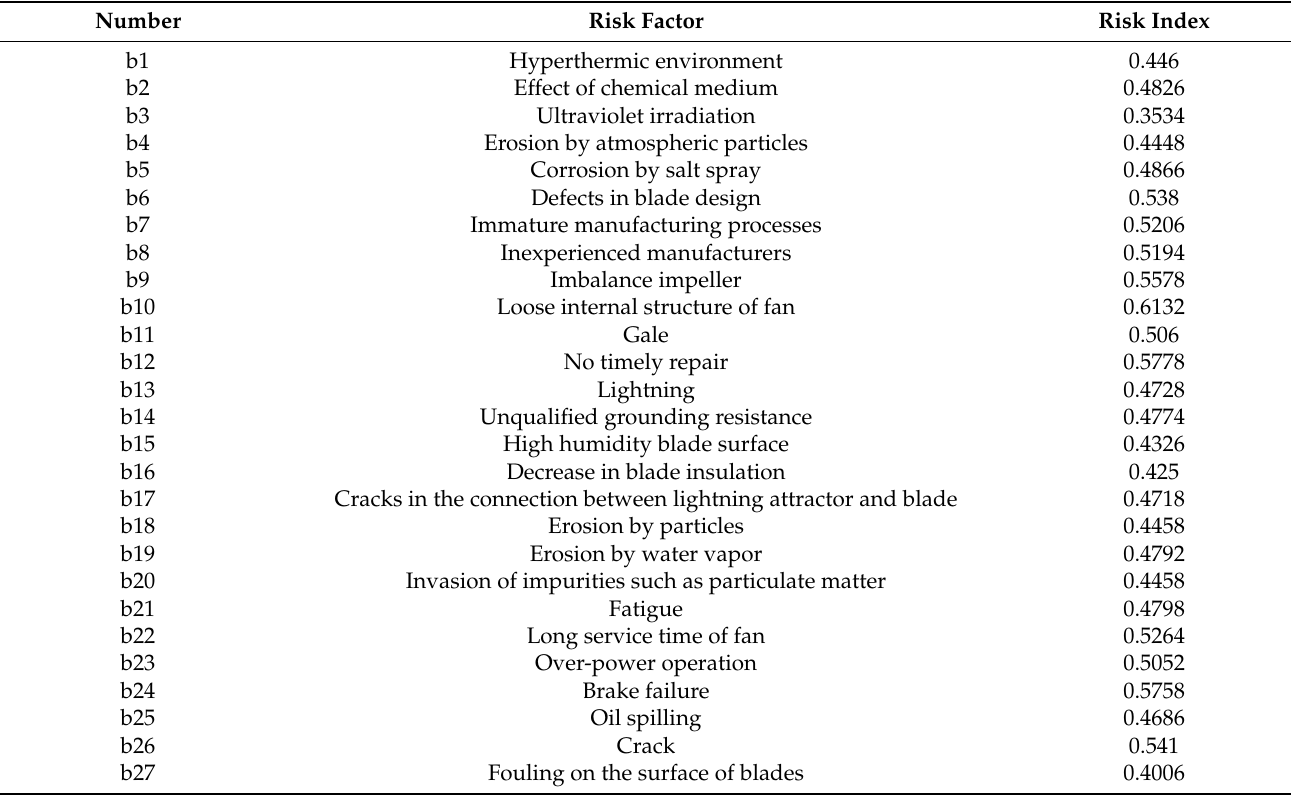
Table 5. Blade failure risk factors of offshore wind farms.